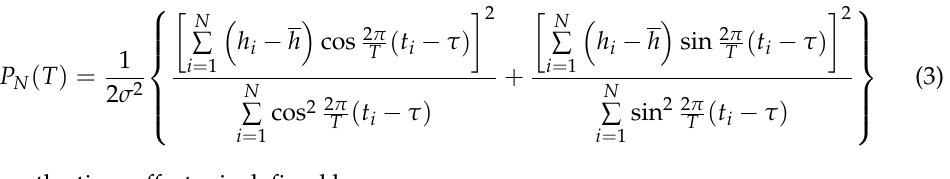
Annual Amplitude Amplitude